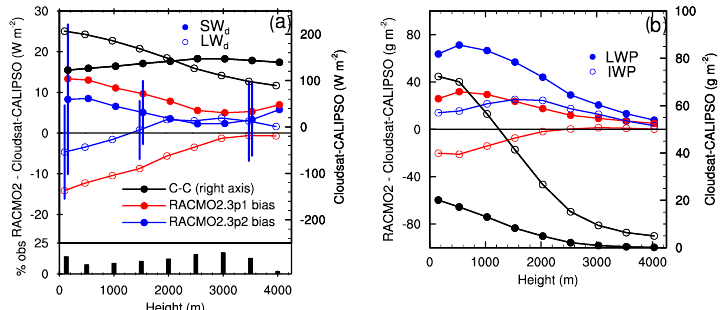
Figure 6. (a) Absolute bias (left axis) in average (2007–2010) modelled downwelling longwave radiation (LW d ) (open circles) and down- welling shortwave radiation (SW d ) (closed circles) and (b) cloud ice water path (IWP) (open circles) and cloud liquid water path (LWP) (closed circles) for RACMO2.3p2 (blue) and RACMO2.3p1 (red) compared to the CloudSat–CALIPSO product (Van Tricht et al., 2016b). Also shown on (a) and (b) are the observational data (black circles, right axis). Error bars in (a) denote the root mean square difference (RMSD) from a statistical comparison of the CloudSat–CALIPSO fluxes and ground-based AWS observations (Van Tricht et al., 2016a), only shown for three bins as based on the elevations of the four ground-based AWSs used. The data are binned in 500m surface elevation intervals (0–250, 250–750, etc.). The bar chart in (a) denotes the percentage of total grid points per elevation bin. To separate LW d and SW d fluxes, x axis locations of each bin in (a) are displaced by 60m.